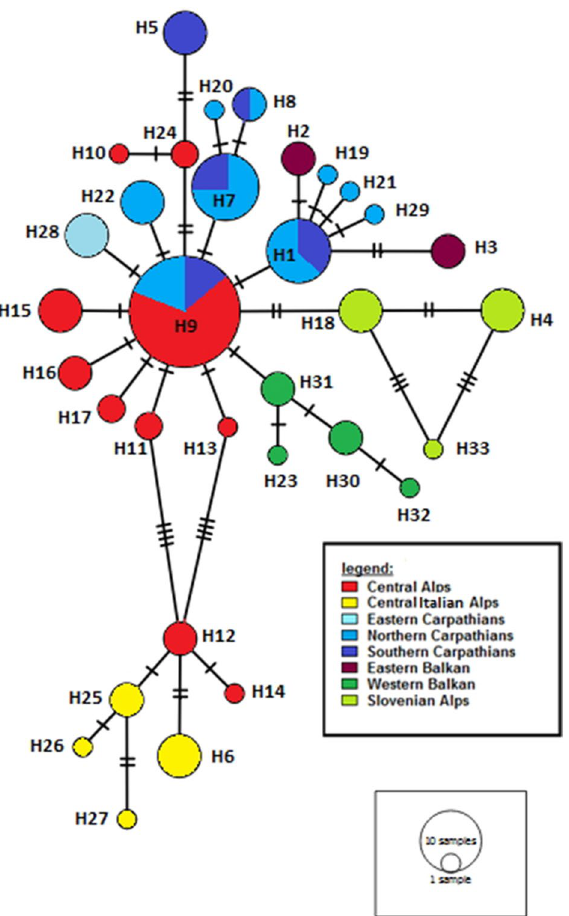
Figure 1. Minimum spanning haplotype network based on the concatenated mtDNA haplotypes (COI, NDI) of E. aethiops. Mutation steps are shown by the number of hatch